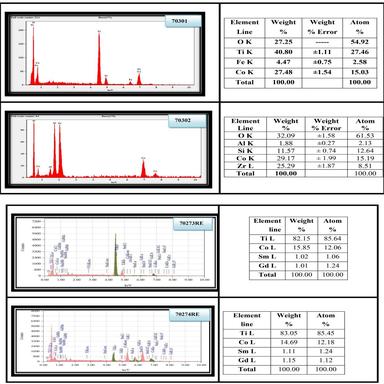
Results of Energy Dispersive Spectroscopy (EDS) graphs and elemental weight and atomic percentage of all four NEG material.